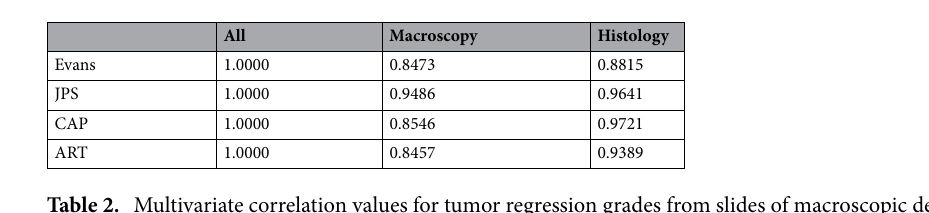
Table 2. Multivariate correlation values for tumor regression grades from slides of macroscopic defined largest tumor and of largest histological tumor versus all slides.